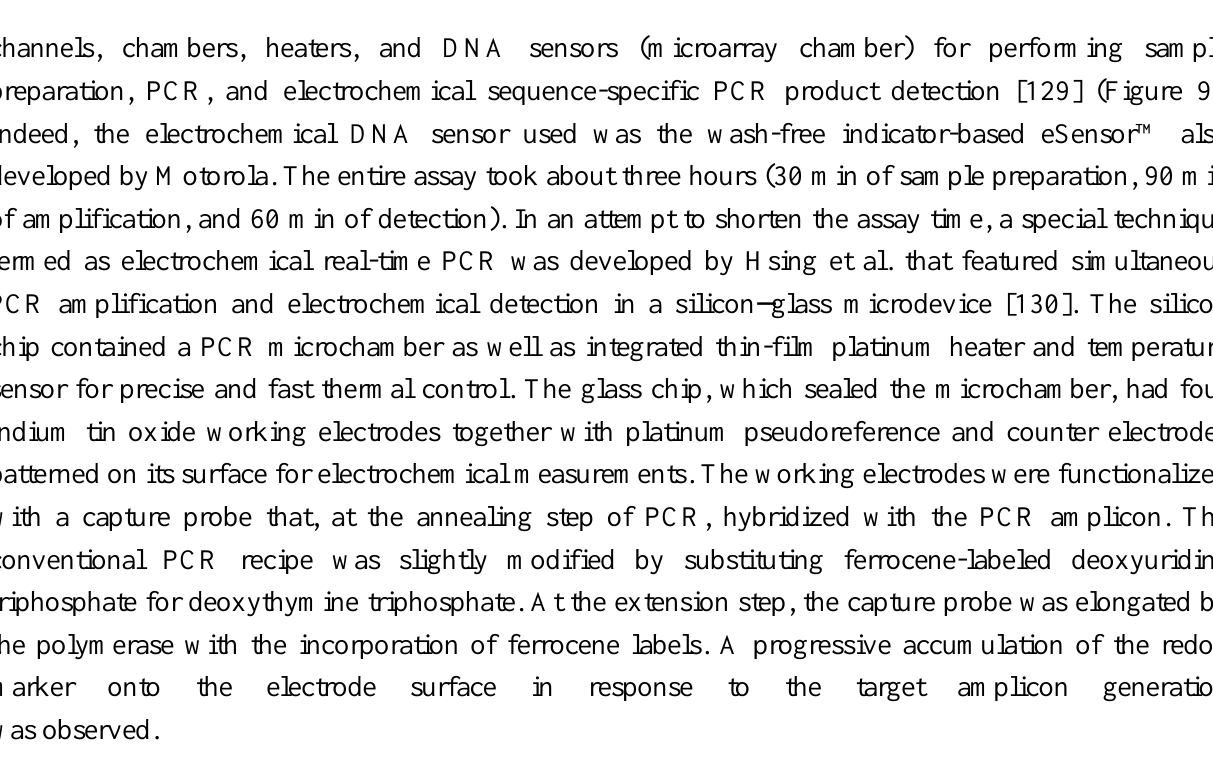
Figure 9. (a) Schematic and (b) photograph of the self-contained, fully integrated DNA biochip developed by Motorola. From Liu et al ., Anal. Chem . 2004 , 76 ,